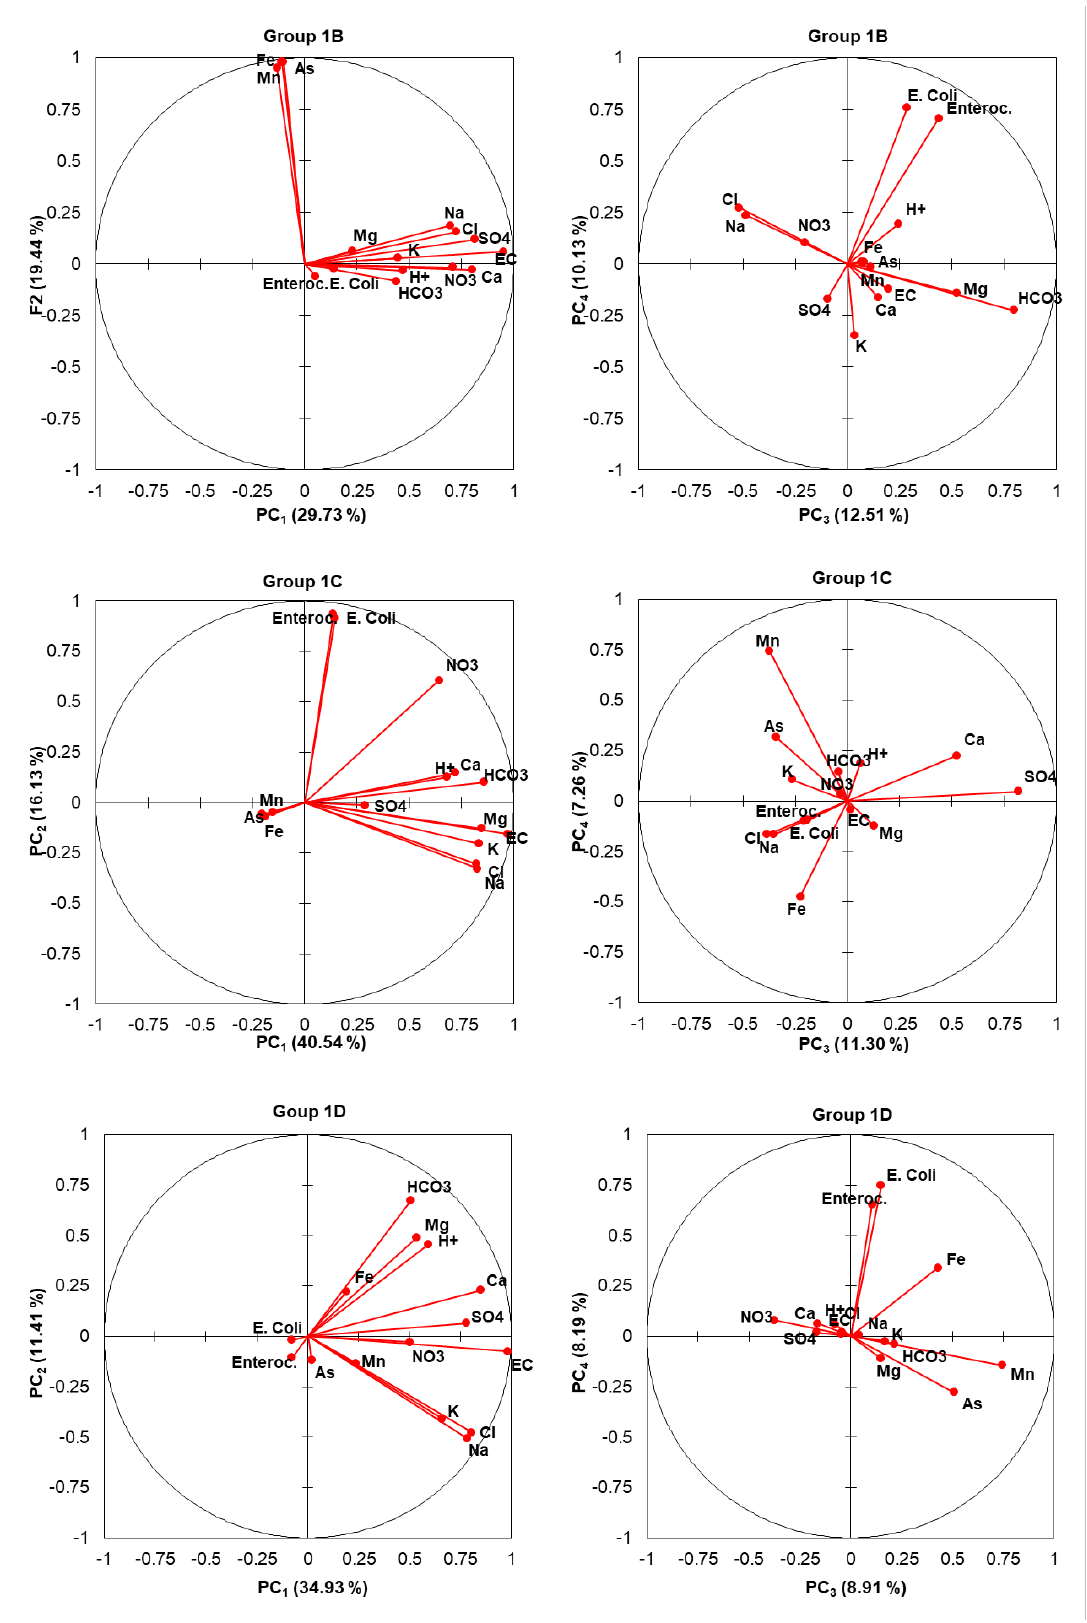
Figure 8. Factorial plans PC1–PC2 and PC3–PC4 for PCA performed on regional dataset, group 1 and its subgroups.